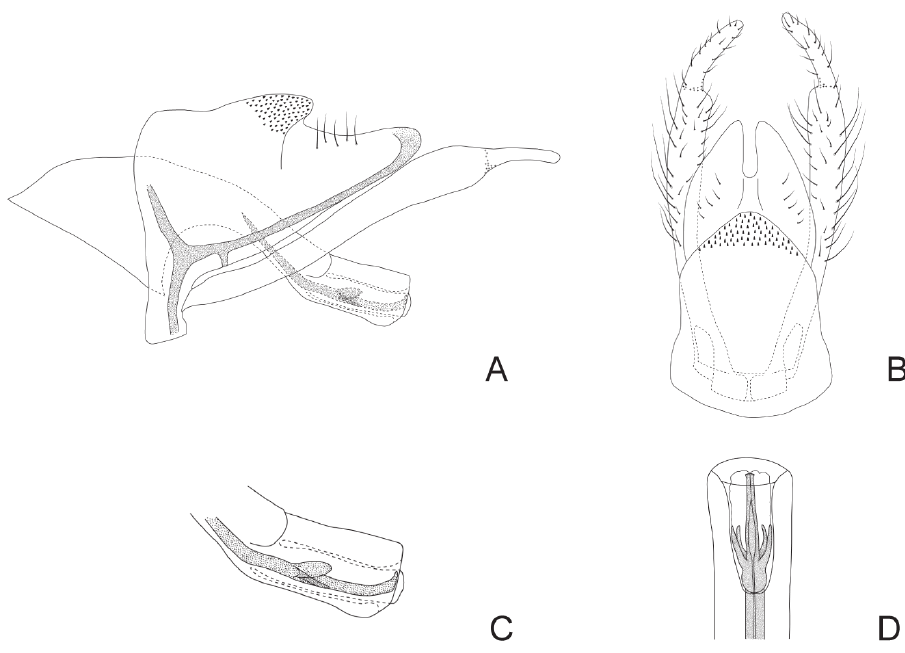
Figure 7. Male genitalia of Smicridea ( Rhyacophylax ) nanda A segments IX, X, inferior appendages and phallus, lateral view B segments IX, X and inferior appendages, dorsal view C tip of the phallus, lateral view D tip of the phallus, dorsal